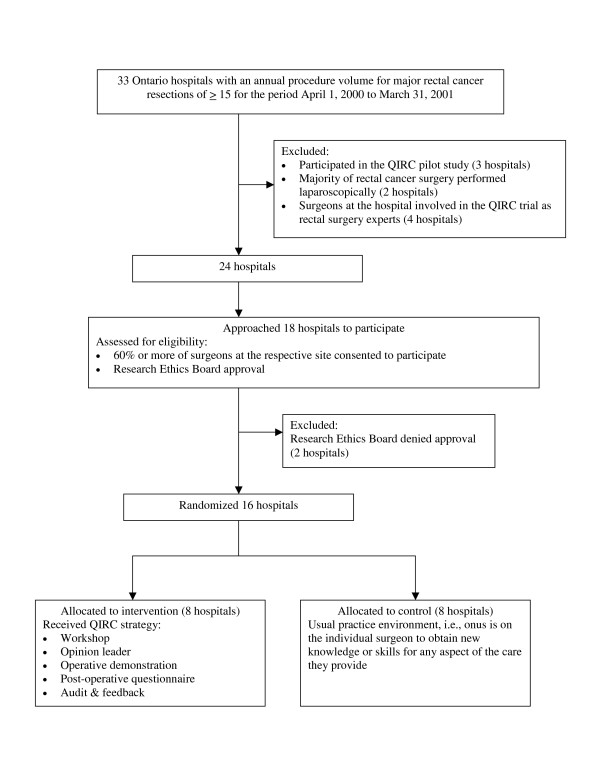
QIRC trial schema.